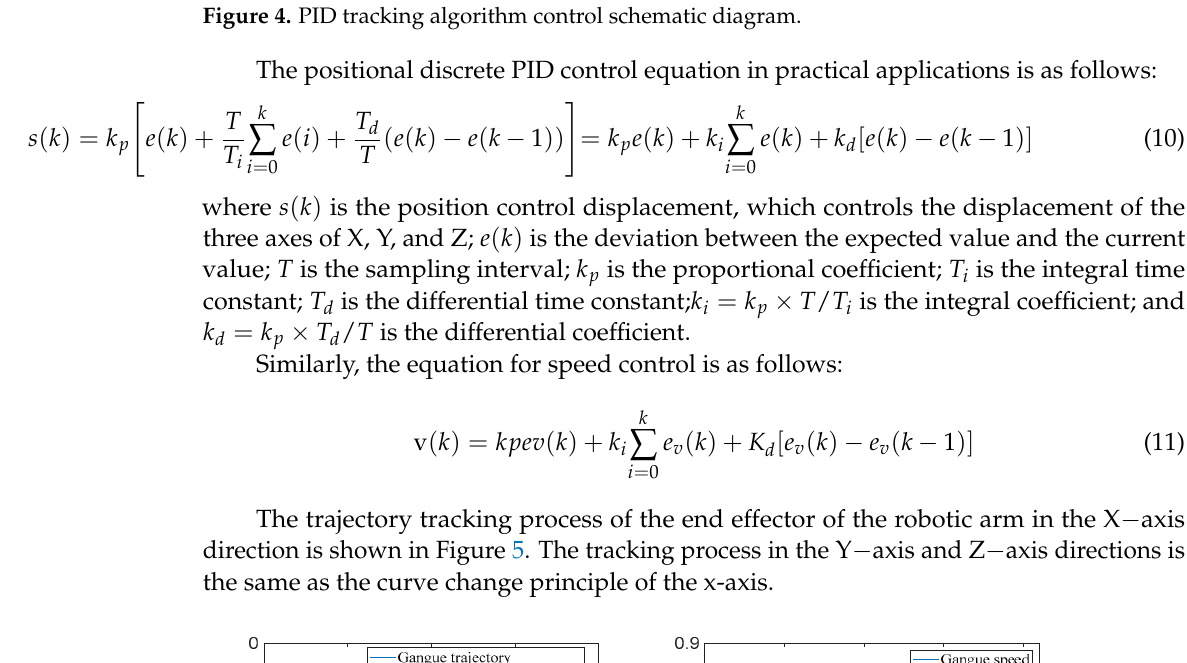
Figure 4. PID tracking algorithm control schematic diagram.